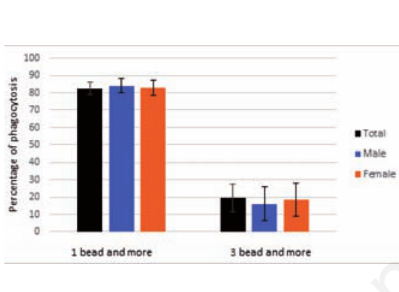
Figure 2. Mean of % phagocytic cells in